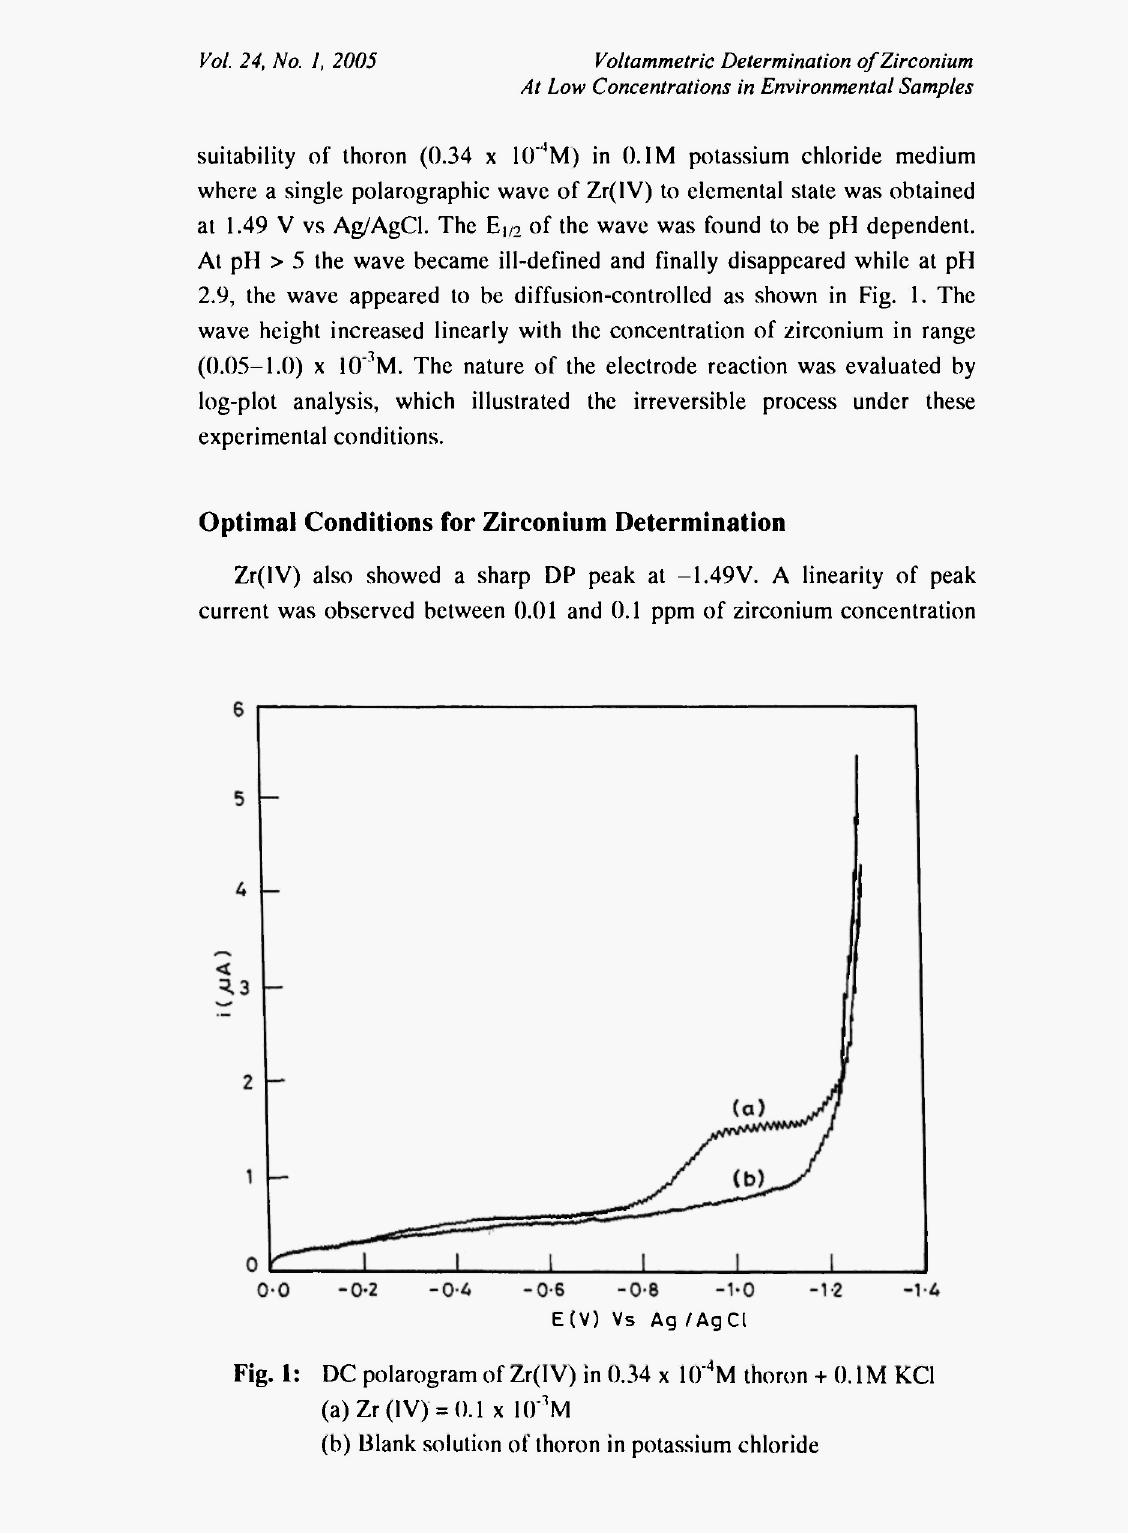
Fig. 1: DC polarogram of Zr(lV) in 0.34 χ 10' 4 M thoron+ 0.1 Μ KCl (a) Zr (IV) = 0.1 χ 10"'lVI (b) Blank solution of thoron in potassium